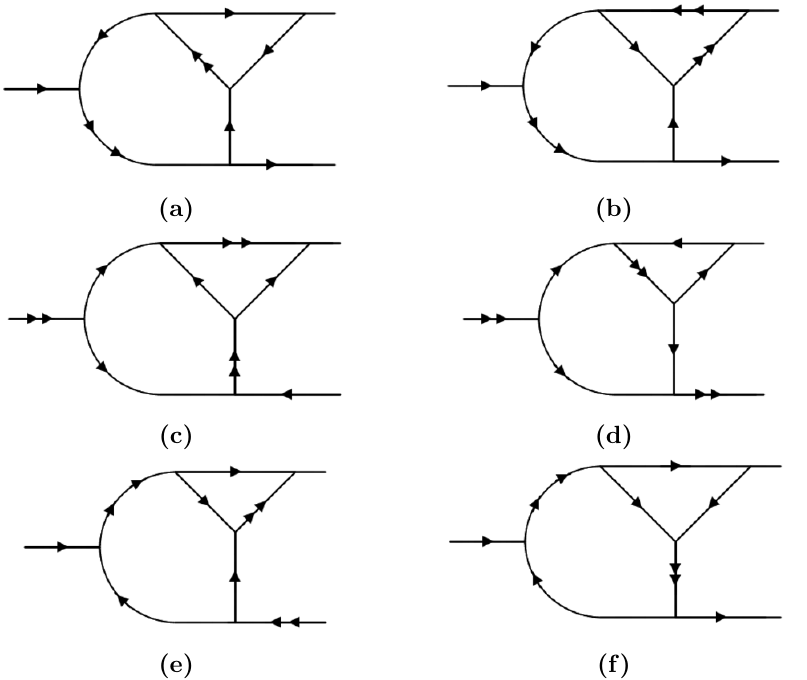
Figure 5. All possible con(cid:12)gurations of arrows in an example of subdiagram. All of them are forbidden by particle number conservation at the upper right